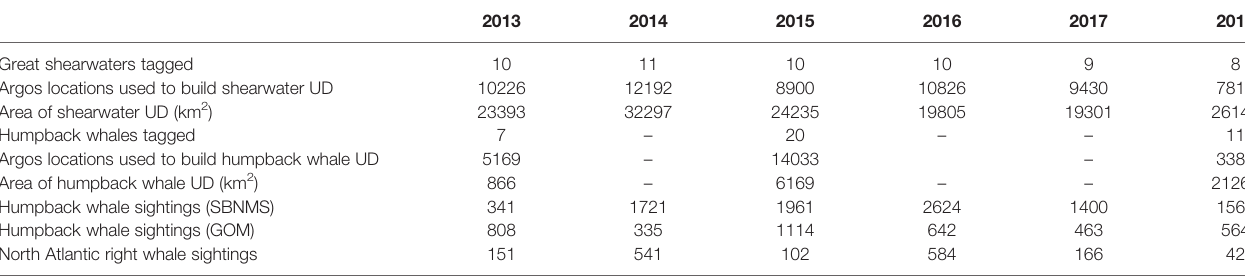
TABLE 1 | Tagging and sightings data summaries used in annual calculations for each year 2013-2018.